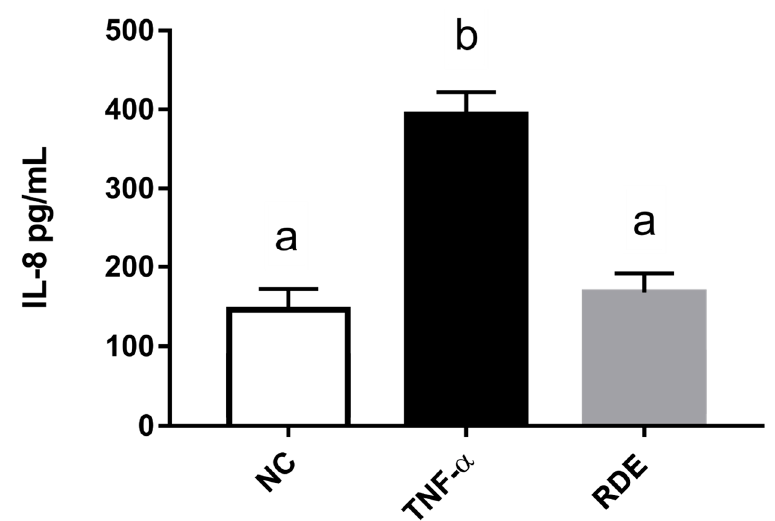
Figure 6. Graphical scheme of the co-culture model of a Caco-2 BBe1/EA.hy926 cell used for the potential evaluation of RDE for preventing CVDs. A final concentration of 100 μ g/mL RDE was added to the apical compartment in which Caco-2 BBe1 cells were grown to form a barrier. After 1 h preincubation, co-cultured EA.hy926 cells were stimulated with TNF- α (2 ng/mL) or ox-LDL (100 μ g/mL) in the basolateral compartment for 4 h and 6 h, respectively. The transported polyphenols were identified and quantified by LC-MS/MS method. The interleukin-8 (IL-8) production and gene expressions of IL-8, tumor necrosis factor-alpha (TNF- α ), interleukin-6 (IL-6), intercellular adhesion molecule-1 (ICAM-1), vascular cell adhesion molecule-1 (VCAM-1), cyclooxygenase 2 (COX-2), and interleukin-10 (IL-10) of the EA.hy926 cells were determined for the purpose of evaluation.